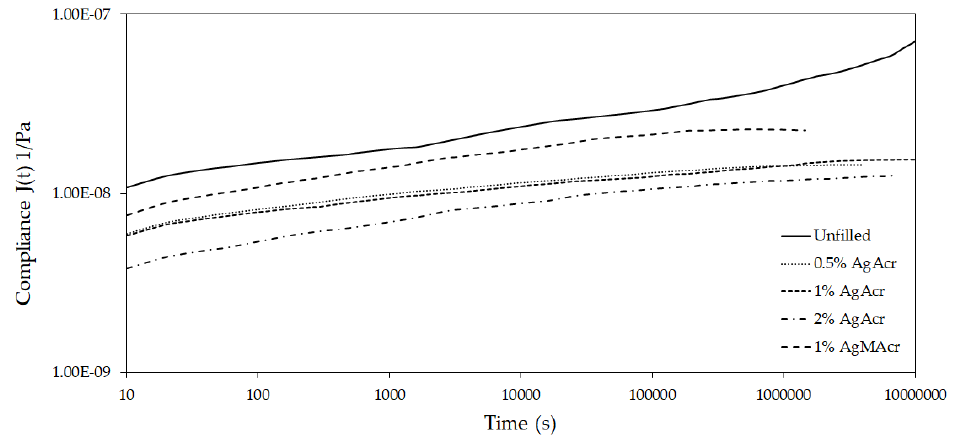
Figure 7. Master curves of compliance as a function of time at the reference temperature of 10 °C for “Unfilled”, “AgAcr x %”, and “AgMAcr 1%” samples.